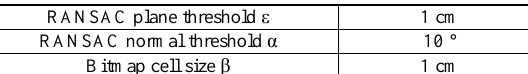
Table 2. Parameters used for segmentation of data sets ‘Classroom’ and ‘Office room’.